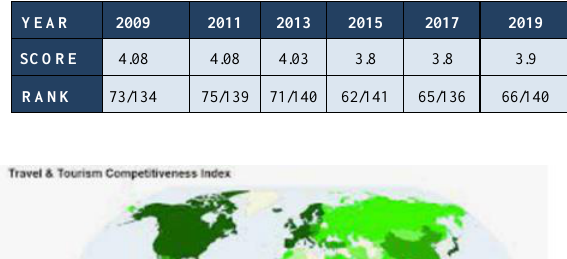
Table 2: The Travel & Tourism Competitiveness Index (TTCI)